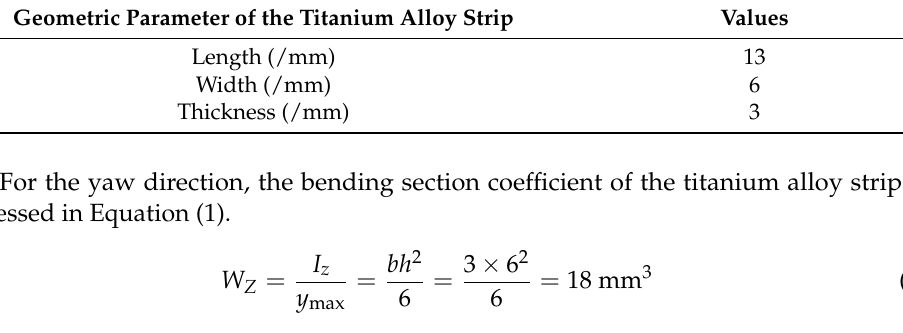
Table 2. Geometric parameter of the titanium alloy strip.